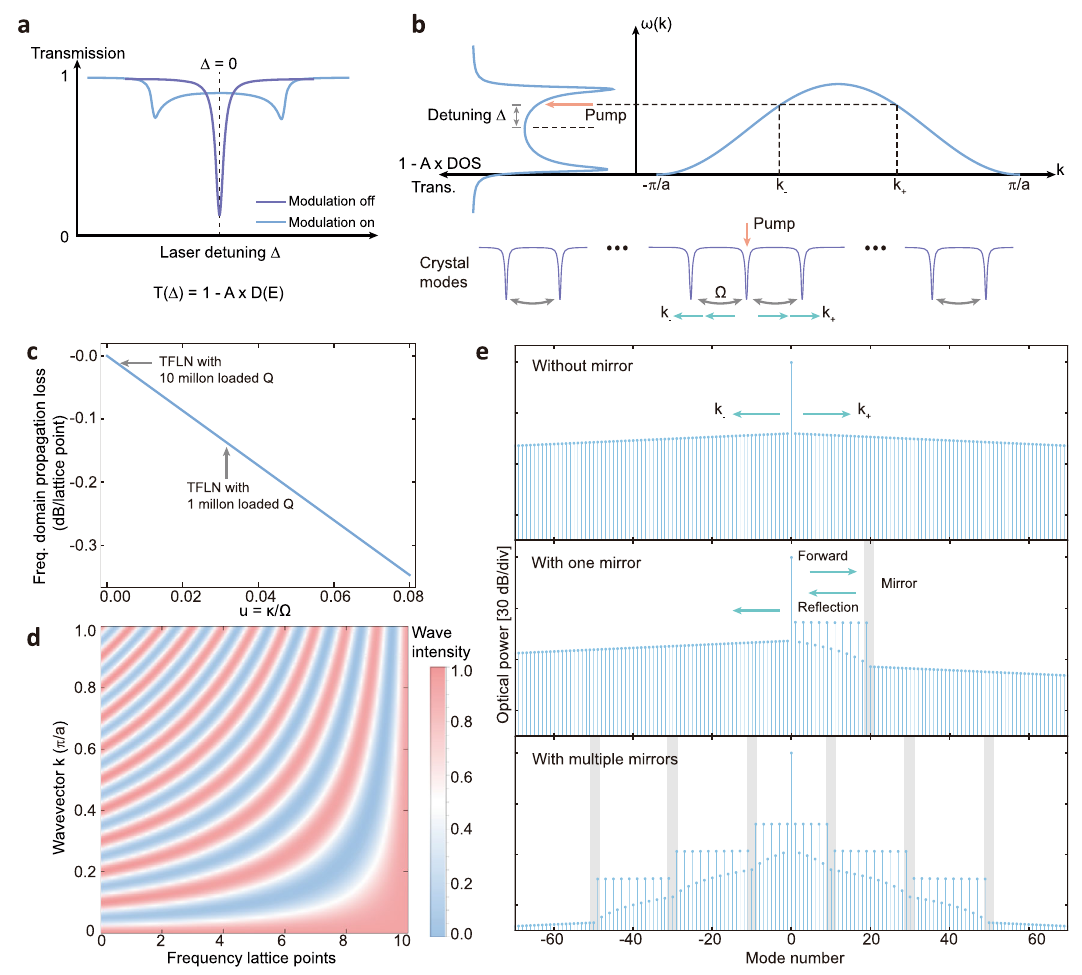
Fig. 2 | Theory of the mirror-induced re fl ection and the trapped states in fre- quencydomain.a Illustrationbetweenthetransmissionspectrumoftheresonator and density of states of the frequency crystal. When the modulation is off, the transmission shows a normal Lorentzian shape. When modulation is on, a fre- quency crystal is formed and each resonance is broadened. The transmission represents a direct link to the DOS, T Δ ð Þ =1 (cid:1) A × D ð E Þ , in which T ð Δ Þ is the trans- mission, D ð E Þ istheDOS,and A representsafactorforDOS(seedetailedforminref. 16). b With modulation on, the resonance shape corresponds to the density of states of the modes propagating in formed frequencycrystal. Then, by controlling the laser detuning Δ , the wave vectorsofthe Blochwaves can becontrolled.In the general case, detuning launches two Bloch waves propagating along the positive and negative direction of the frequency crystal, with wavevectors k + and k (cid:1) , respectively,asdeterminedbythebandstructureofthecrystal. c Propagationloss